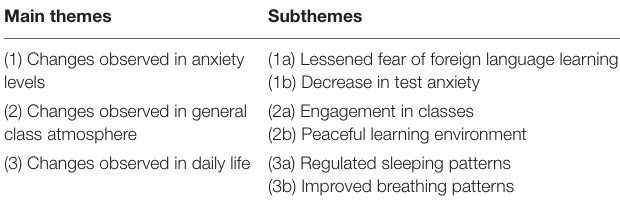
TABLE 5 | Listening and Reading Comprehension Tests (LRCT) Mann-Whitney U test results.